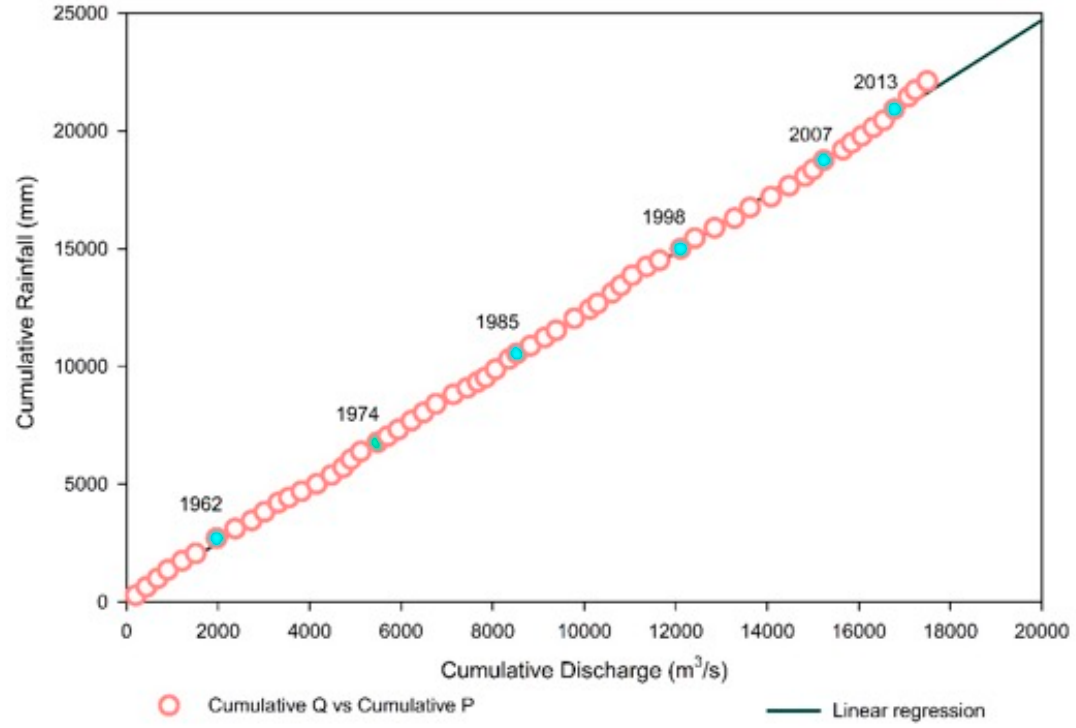
Figure 3. Double-mass curve for cumulative rainfall and cumulative discharge of the Lhasa River for the time span of 1956 − 2016. The years for change in hydrological time series are highlighted and supported by text.